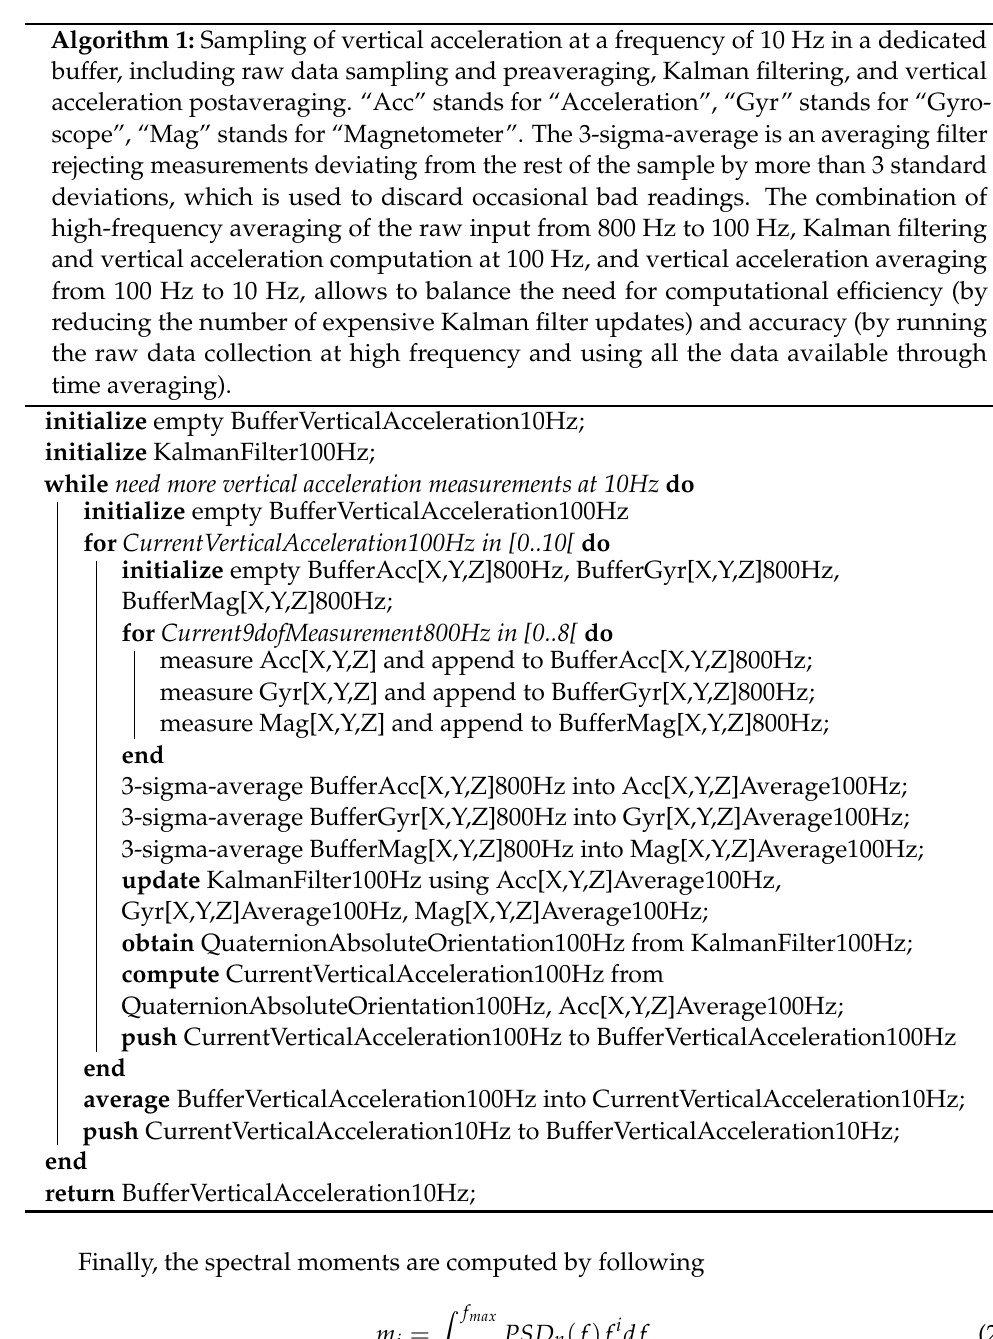
Algorithm 1: Sampling of vertical acceleration at a frequency of 10 Hz in a